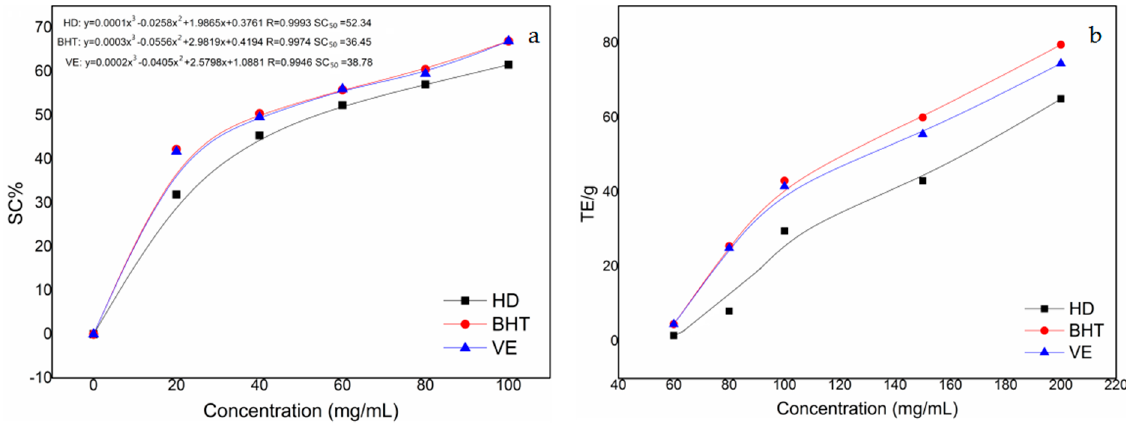
Figure 5. Results of ( a ) DPPH free radical scavenging activity and ( b ) ferric ion reducing antioxidant power (FRAP) assay.